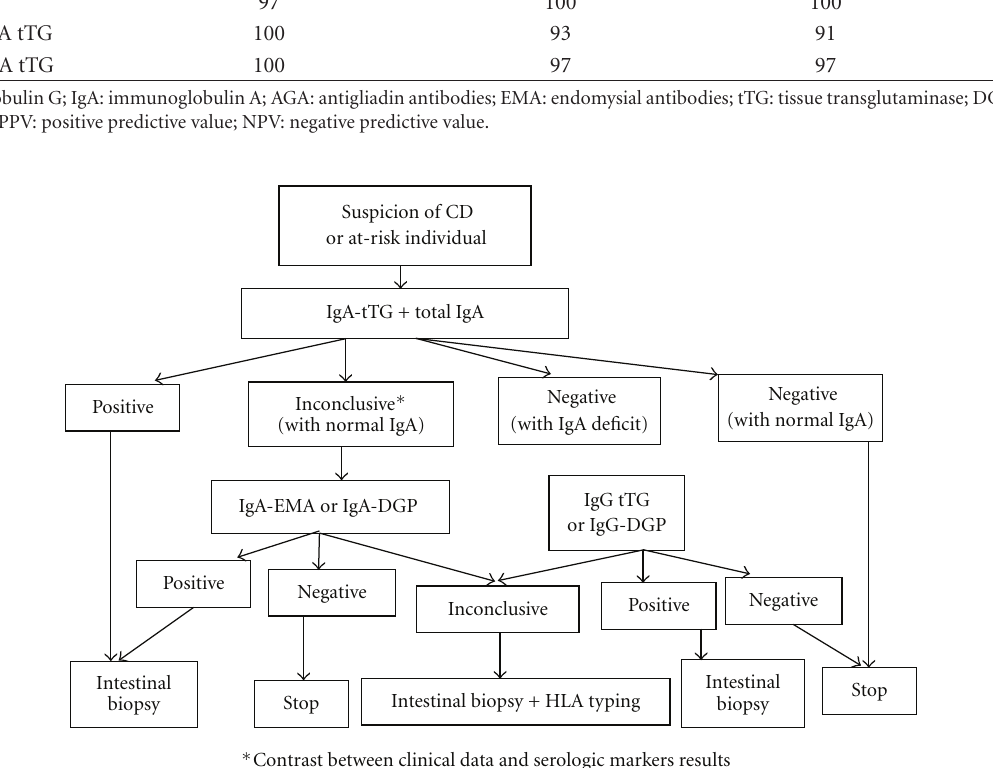
Figure 2: Algorithm proposal for biologic diagnosis of celiac